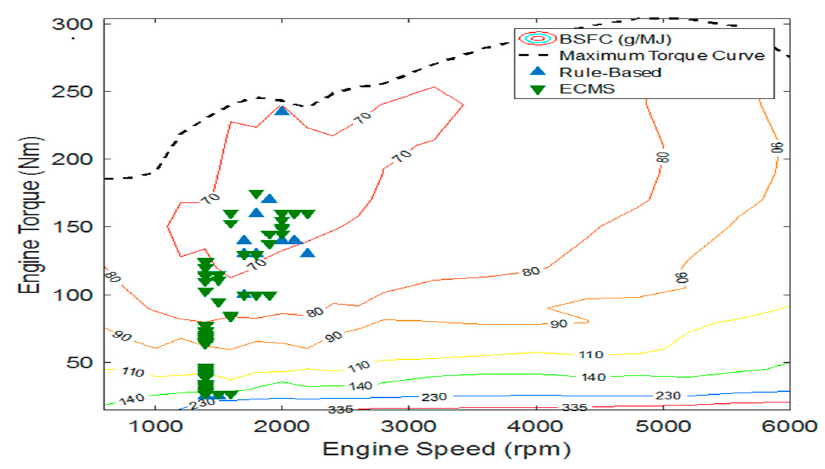
Figure 11. Comparison of engine operating points when driving in urban areas.